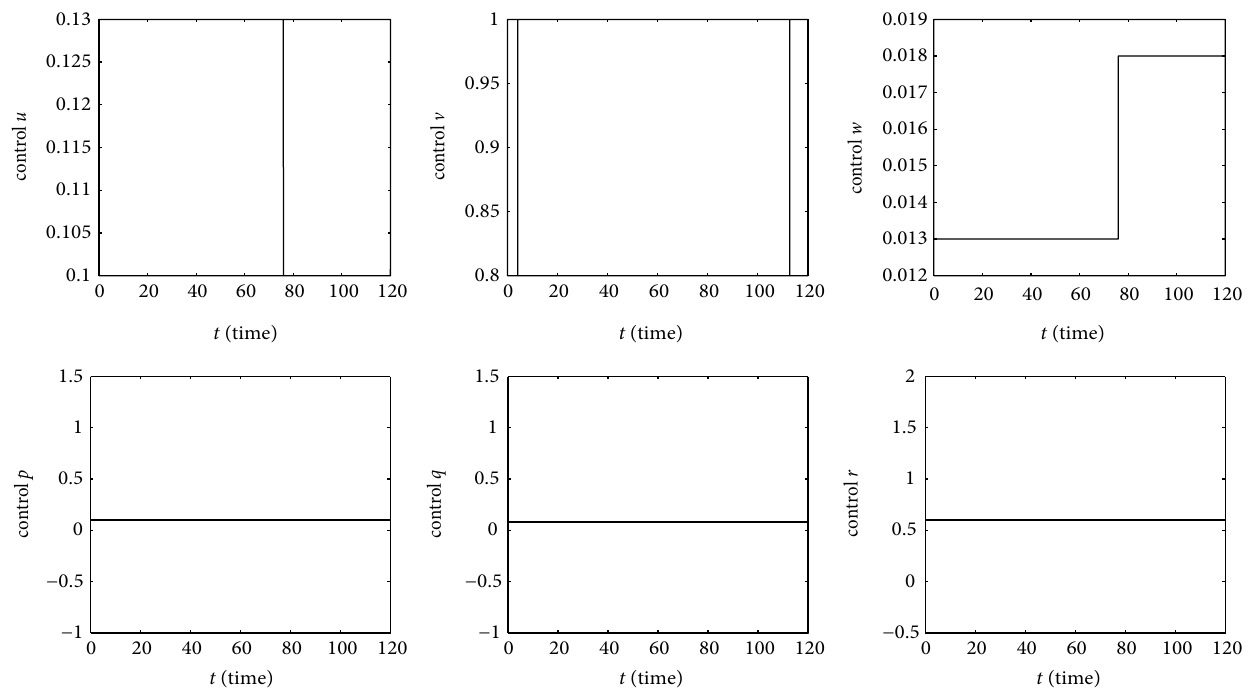
Figure 6: Optimal controls for 푇 = 120.0 : upper row: 푢